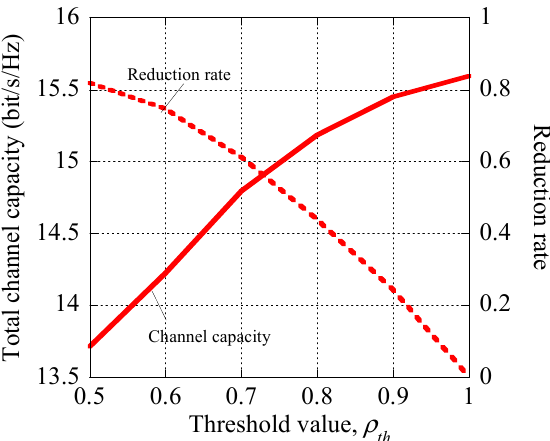
Figure 6. Total channel capacity and reduction rate vs. threshold value.